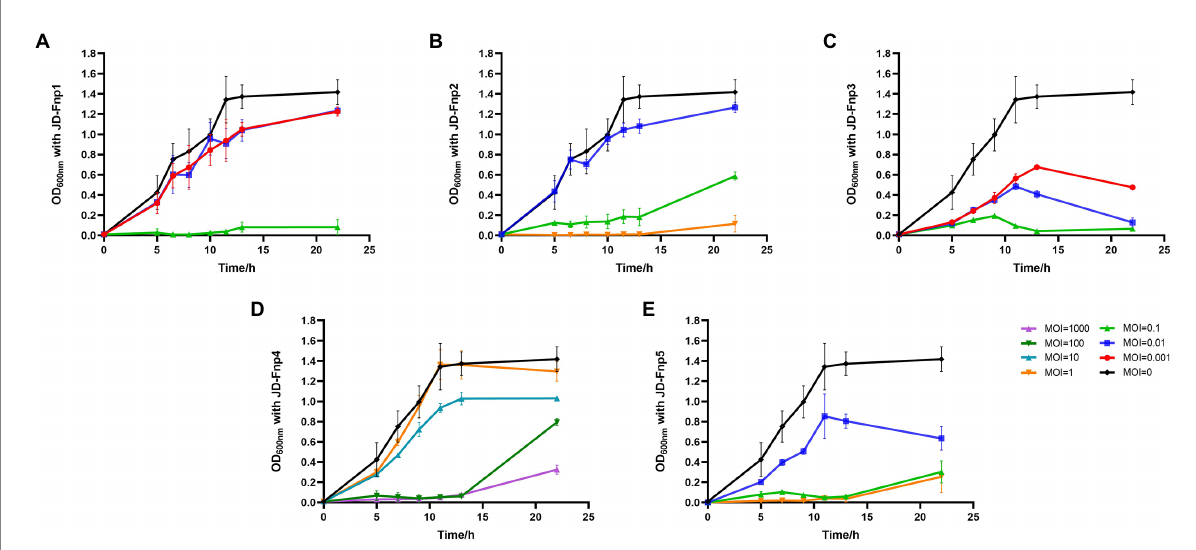
FIGURE 6 In vitro bactericidal activity of JD-Fnp1 ~ JD-Fnp5 with host bacteria JD-Fn1. (A) JD-Fnp1; (B) JD-Fnp2; (C) JD-Fnp3; (D) JD-Fnp4; (E) JD-Fnp5. F. nucleatum strain JD-Fn1 was infected by JD-Fnp phages with different MOI. The x-axis represents the co-culture time of JD-Fnp phage and JD- Fn1; the y-axis represents the change of OD 600 in the mixture. Data are displayed as the means ± SD (error bars) from three independent experiments.